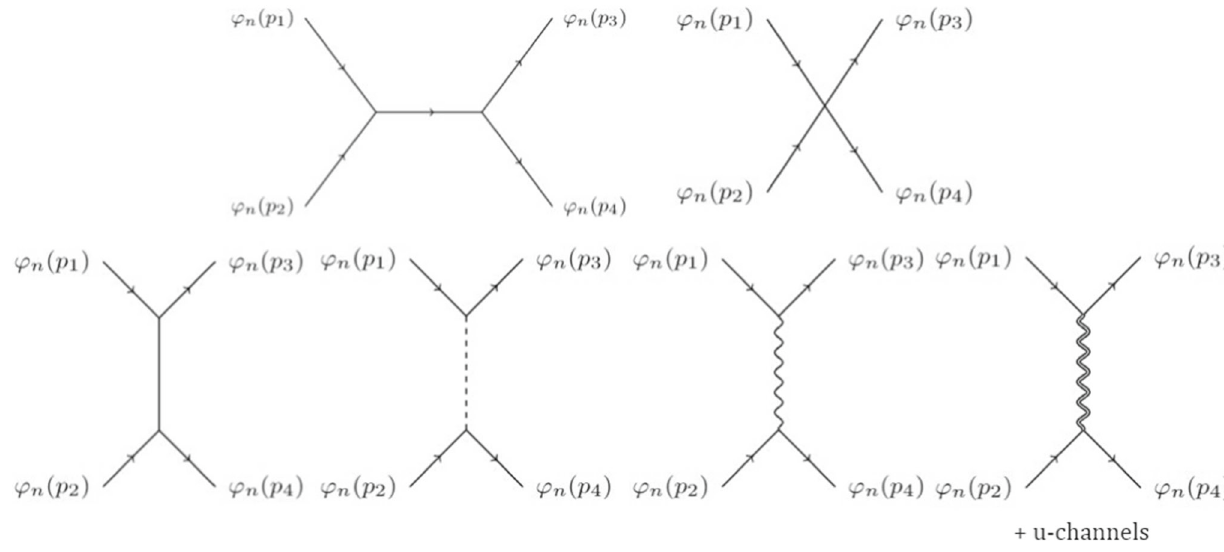
Fig. 7 Feynman diagrams for the ϕ n ϕ n → ϕ n ϕ n scattering in the t -channel ϕ 2 n particle and from a 4-point contact term. These are the diagrams that are presented in Fig.7 and lead